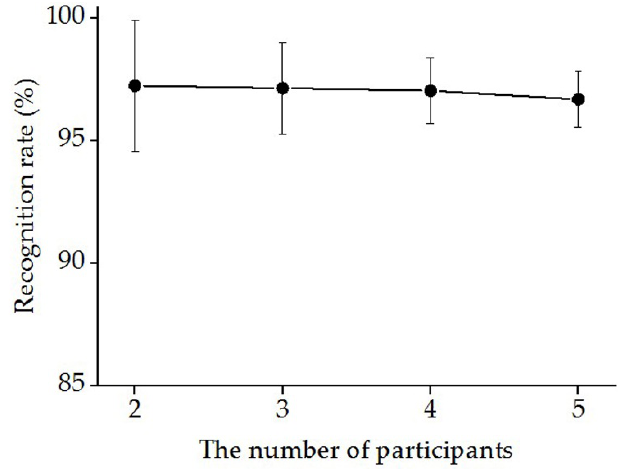
Figure 9. The distance between the centroids (Equation (8)) across the five gestures of all participants. All of the distance values were normalized.